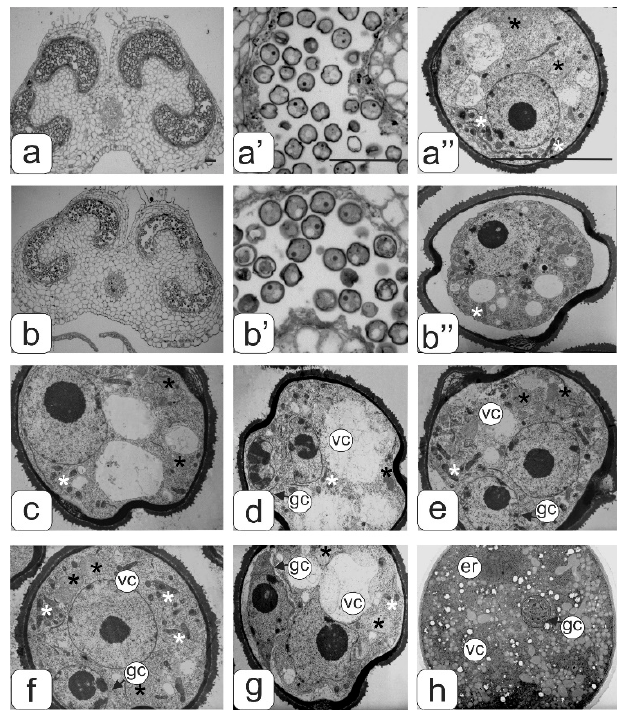
Figure 2. Semi-thin cross sections of anther from the control ( а , a’ , a’’ ) and transgenic tomato plants without abnormalities ( b , b ’, b ’’) at the microspore stage. Microspore ultrastructure at some asymmetric mitosis stages ( с – g ), and mature pollen grain ultrastructure ( h ). Symbols: er– endoplasmic reticulum; g с –generative cell; vc–vegetative cell; black asterisks–plastids, white asterisks–mitochondria. Bar—100 μ m (for semi-thin sections: a–b’) and 10 μ m (for ultrathin sections: a”; b”; c–h).